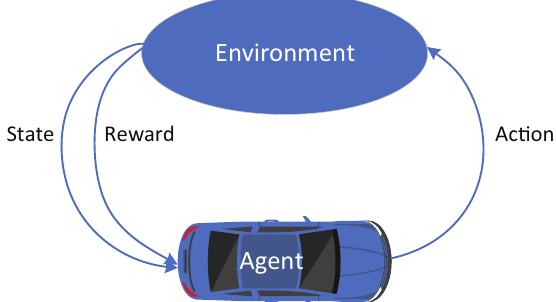
Figure 8. The structure of the reinforcement learning